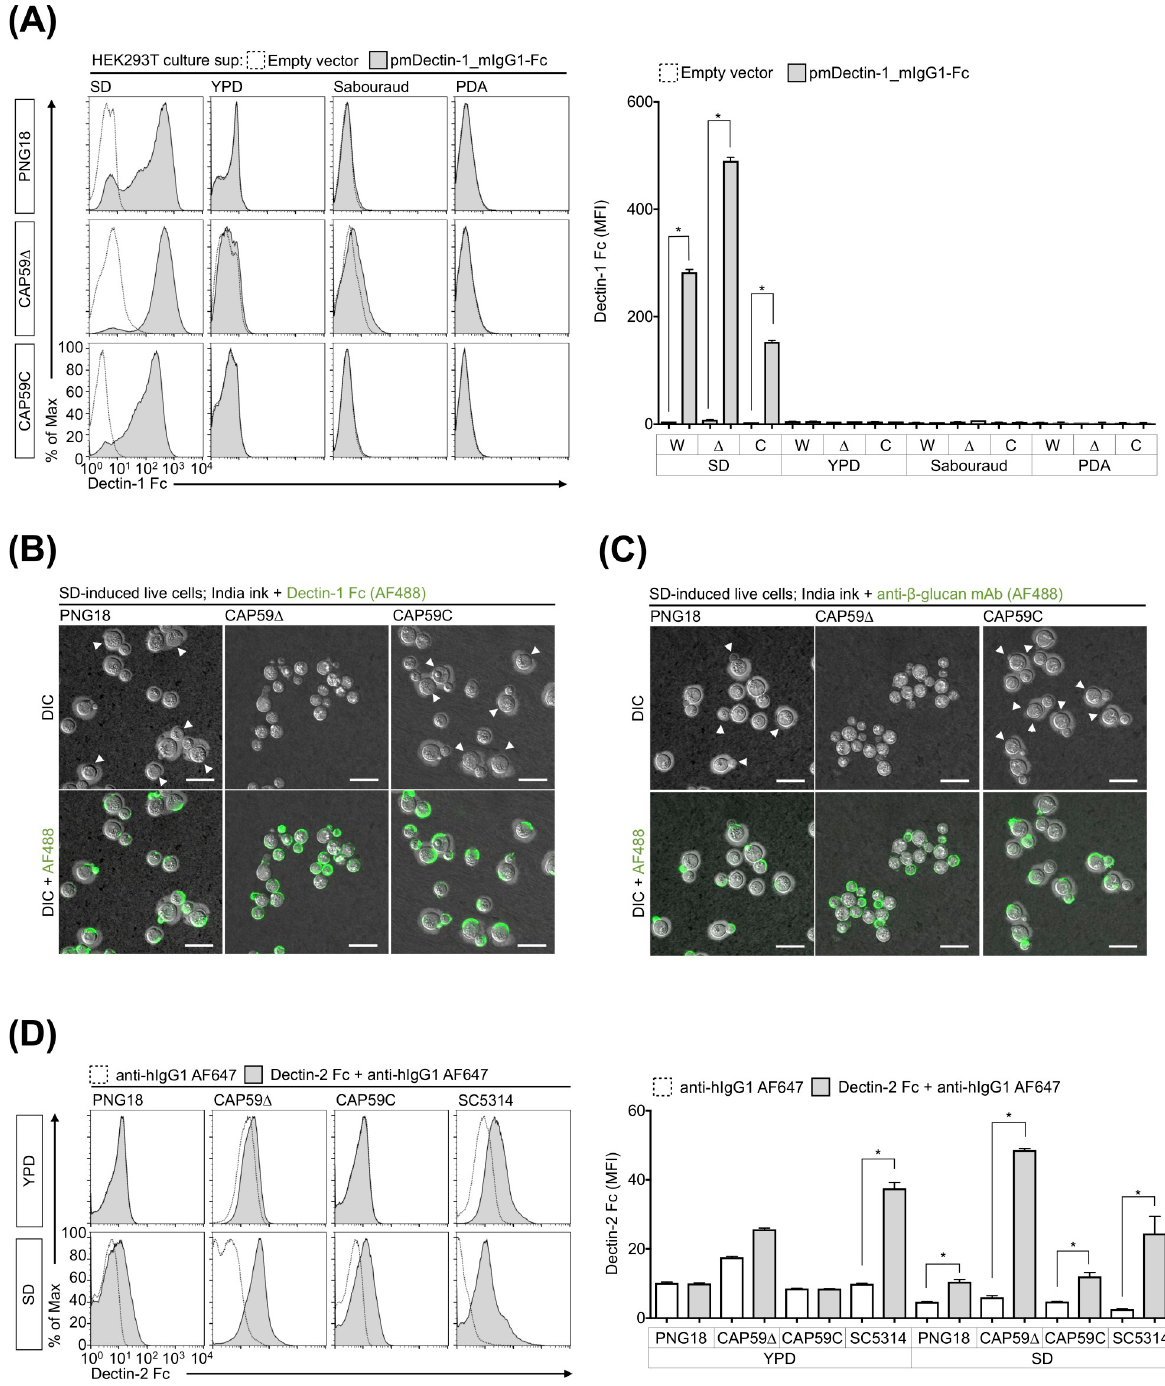
Fig 3. C . gattii acapsular strain CAP59 Δ also requires SD medium to induce dectin-1 and dectin-2 ligands. Deposition of Fc dectin-1 (A and B), anti- β -1,3-glucan mAb (C), and Fc dectin-2 (D) on fungal cells were evaluated as described in Fig 1 and Fig 2. Live fungal cells (B and C) and heat-killed fungal cells (A and D) were used for the deposition assay. The fluorescent signal was detected by flow cytometry (A and D) and confocal laser-scanning microscopy (B and C). Capsule formation was observed using the conventional India ink method. Arrow heads indicate the capsule erosion sites on C . gattii cells. Bar = 10 μ m. Representative bar graph (mean ± SDs) from three independent experiments are shown. � : P < 0.05 as determined via an unpaired t -test, W: C . gattii PNG18 (parent strain), Δ : C . gattii CAP59 Δ ( CAP59 deletant, acapsular strain), C: C . gattii CAP59C ( CAP59 revertant, capsular